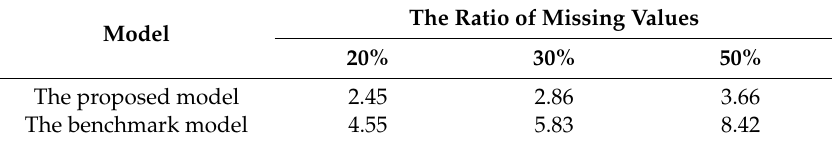
Table 2. ARL 1 values of the proposed model and benchmark model in the real case.